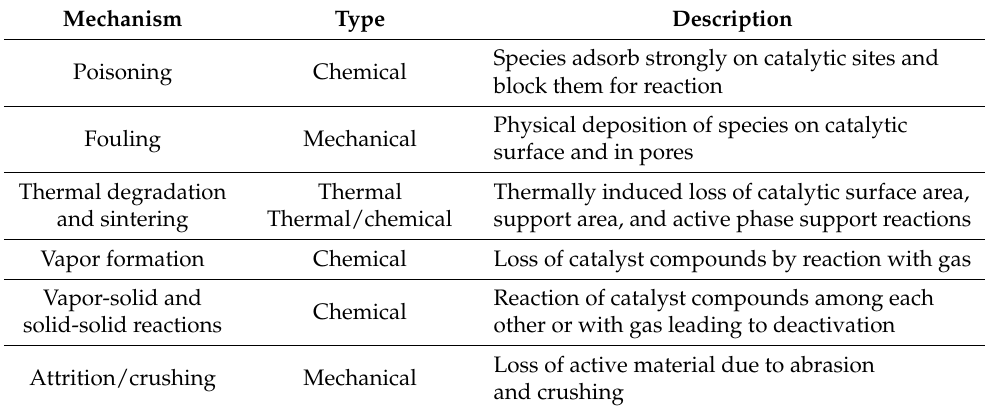
Table 3. Types and mechanisms of catalyst deactivation